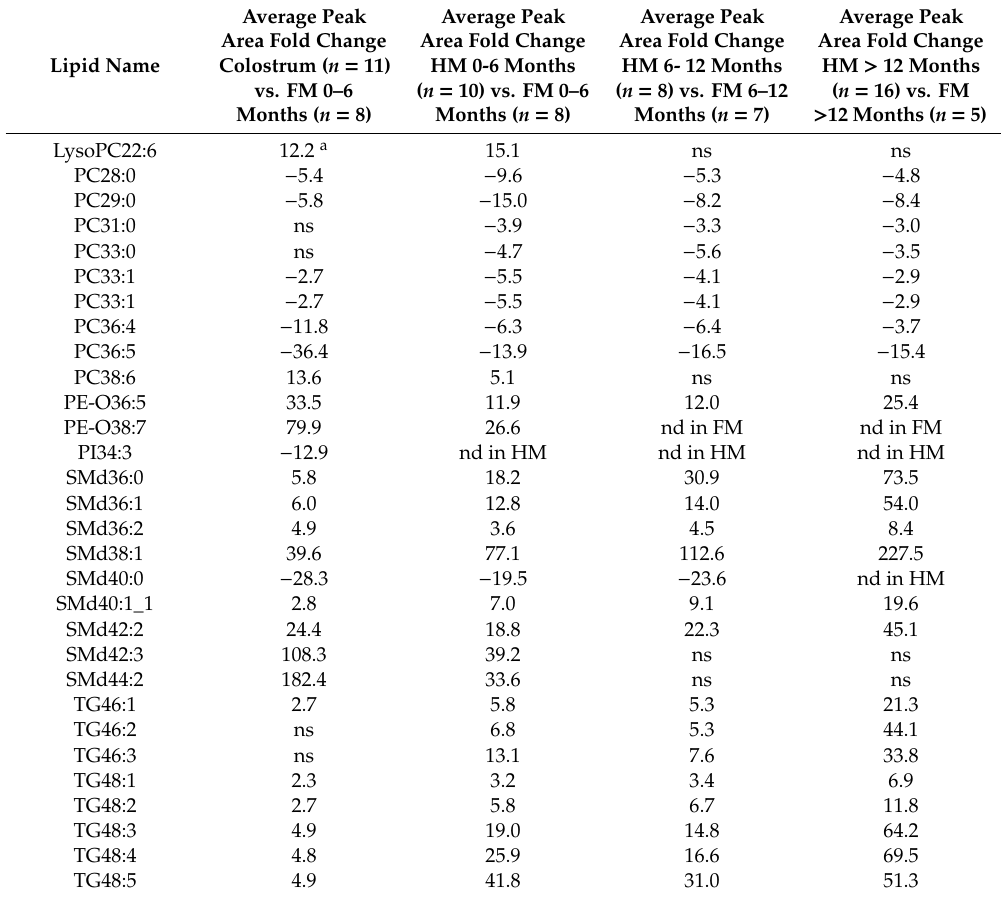
Table 4. The short-list of lipids indicating a statistically significant di ff erence between HM and FM samples in the di ff erent lactation stages and age range targets according to ANOVA unequal variance test (multiple testing correction: Benjamini–Hochberg, p <